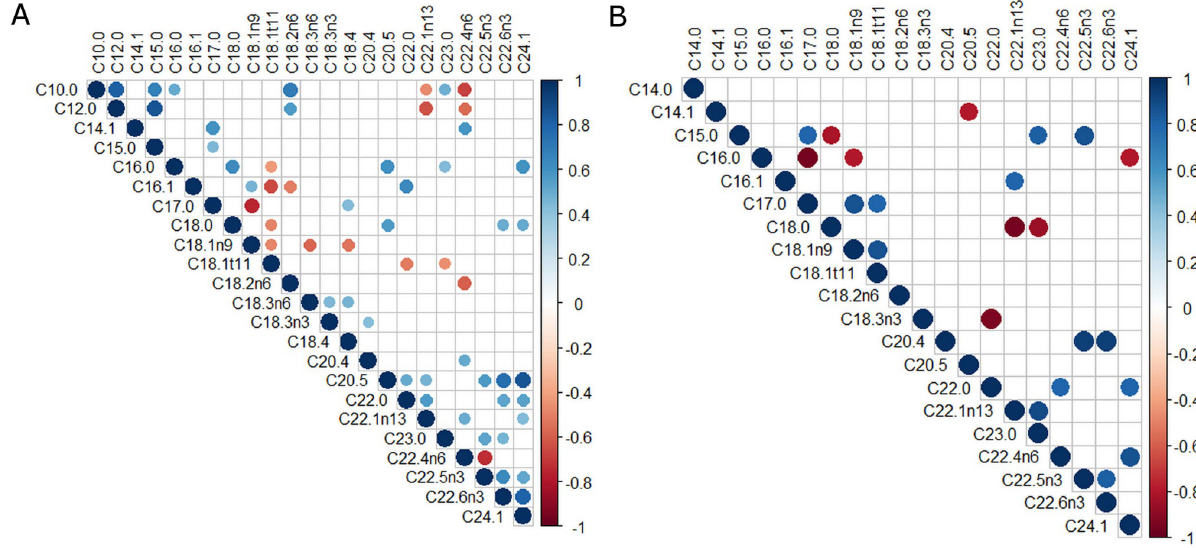
Fig 1. Correlations of FAs percentage in tumor. A. SCC grade 1+2. B. SCC grade 3. Red or blue dots on the correlogram, depending on the direction of the correlation, the dot size in the correlation matrix is proportional to the strength of the correlation.